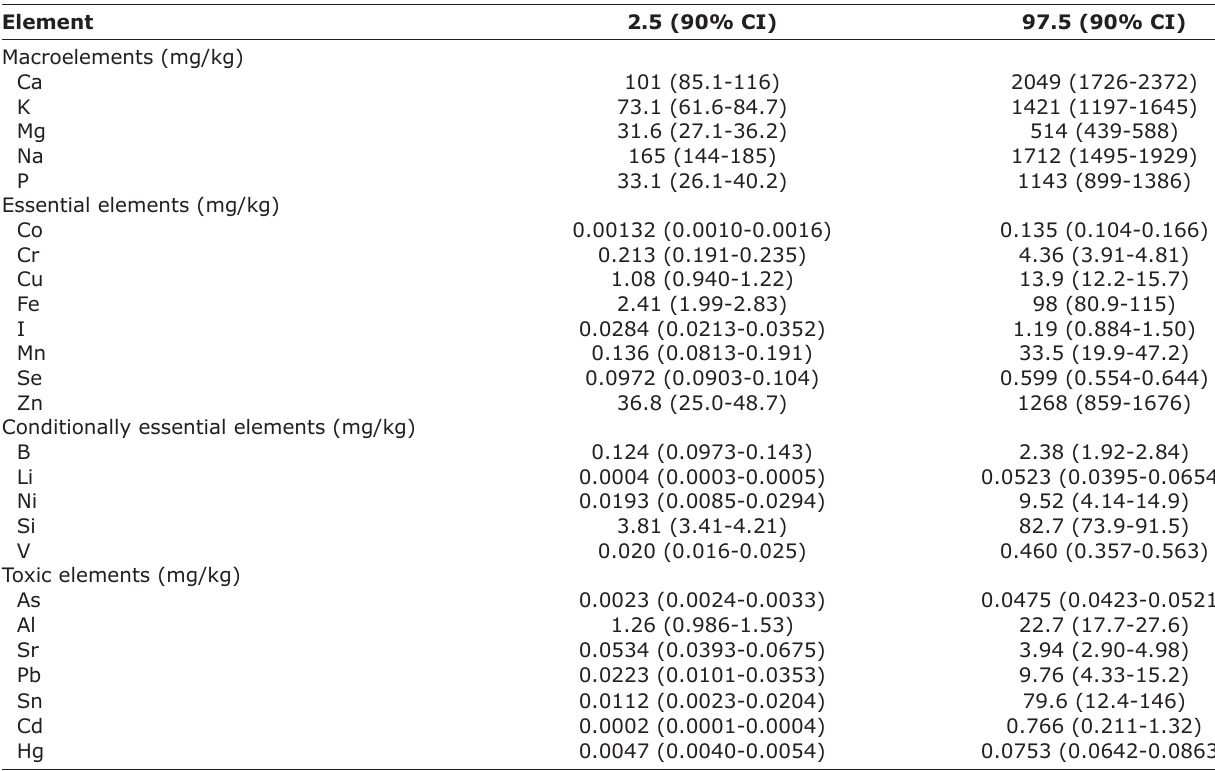
Table-5: Reference ranges of concentrations of essential and toxic elements in laying hens at the age of 100-140 days.